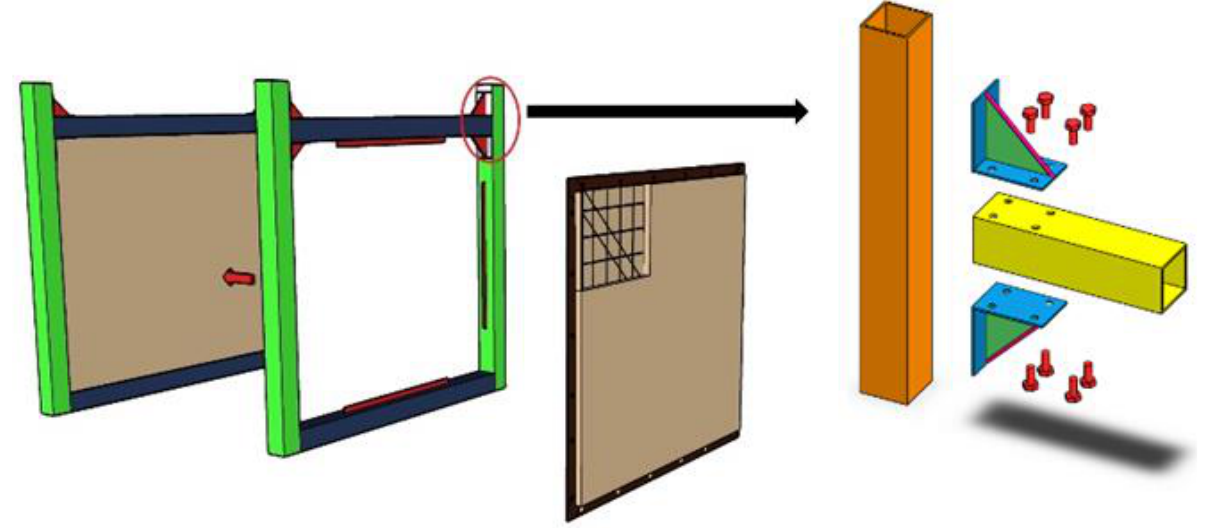
Figure 1. Assembly diagram of composite shear wall with concealed bracings in steel-tube frame. Table 1. Design parameters of the composite shear wall.